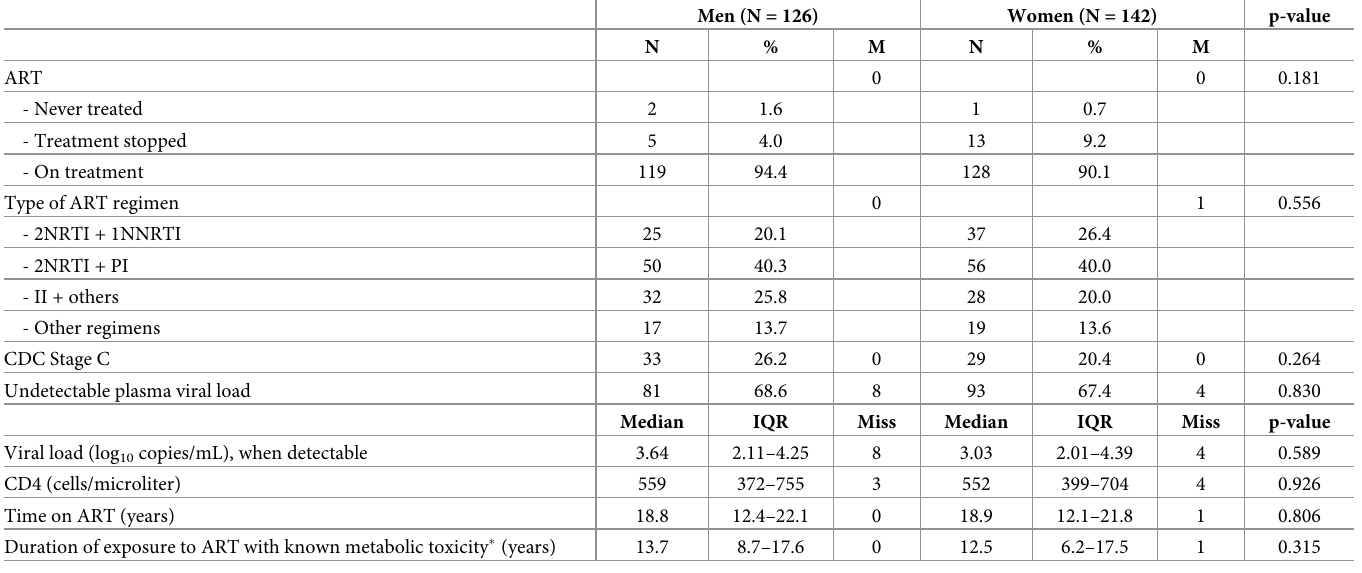
Table 2. Comparison of antiretroviral treatment and immune-virological status, according to gender, of patients infected with HIV since childhood from the ANRS CO19—COVERTE